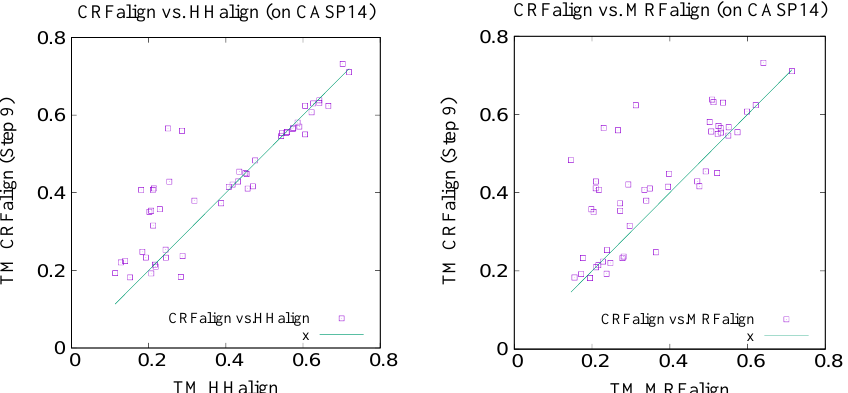
Figure 15. Comparison of the TM scores of structure models on hard targets of CASP14 by CRFalign (five-state model, step 9) against HHalign ( left ) and MRFalign ( right ) respectively.